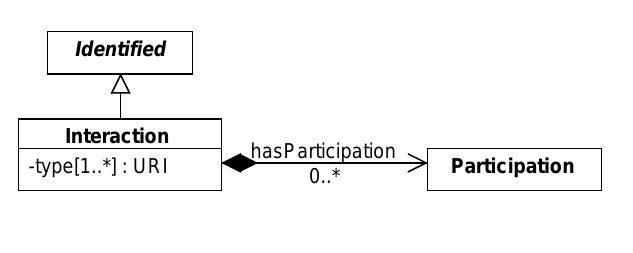
Figure 12: Diagram of the Interaction class and its associated properties.